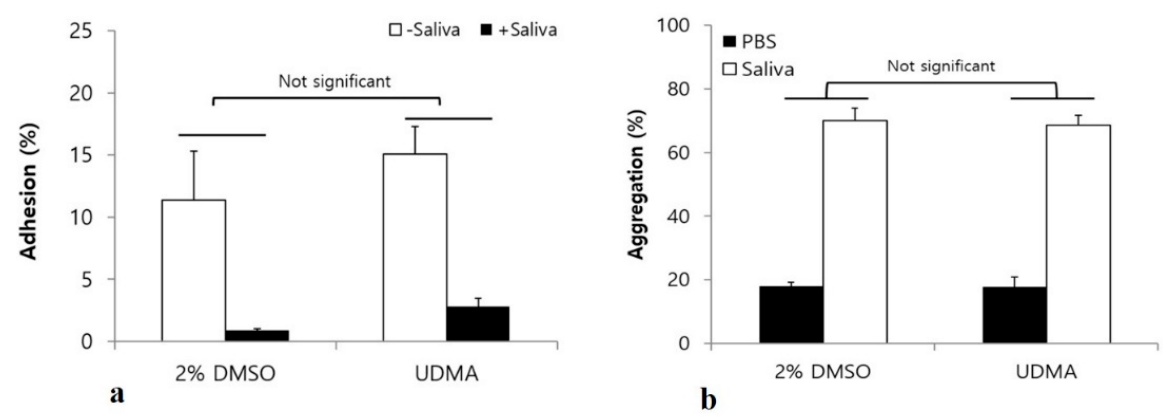
Figure 10. Bacterial adhesion ( a ), and aggregation ( b ) assay to analyze the effects of UDMA on interactions between S. mutans UA159 and saliva. Although saliva coating significantly inhibited the adhesion of S. mutans , the presence of saliva did not significantly alter the effects of UDMA on bacterial adhesion (two-way analysis of variance). The bacterial aggregation assay indicated no significant difference between the cells grown in the presence and absence of UDMA. DMSO was used as a vehicle for UDMA, and cells grown in the absence of UDMA served as the control (2% DMSO). Data are representative of three independent experiments and are expressed as mean ± standard deviation values.